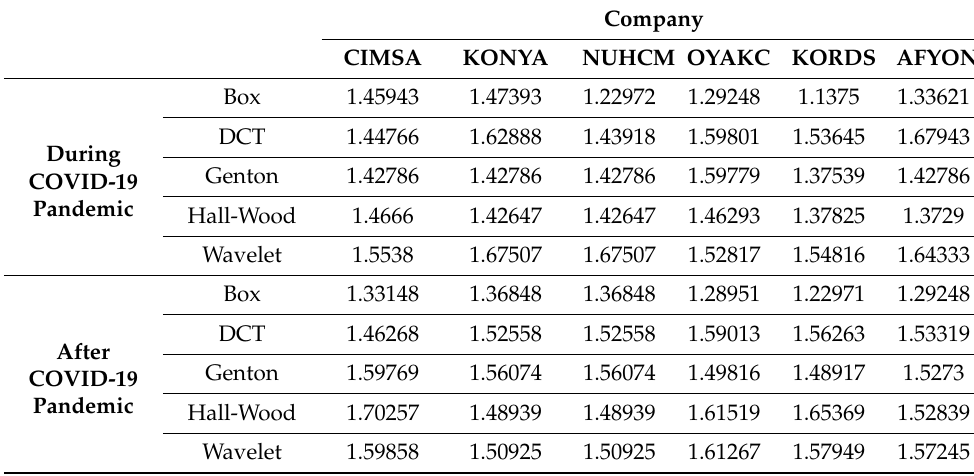
Table A8. Fractal dimensions for the stone–soil-based manufacturing